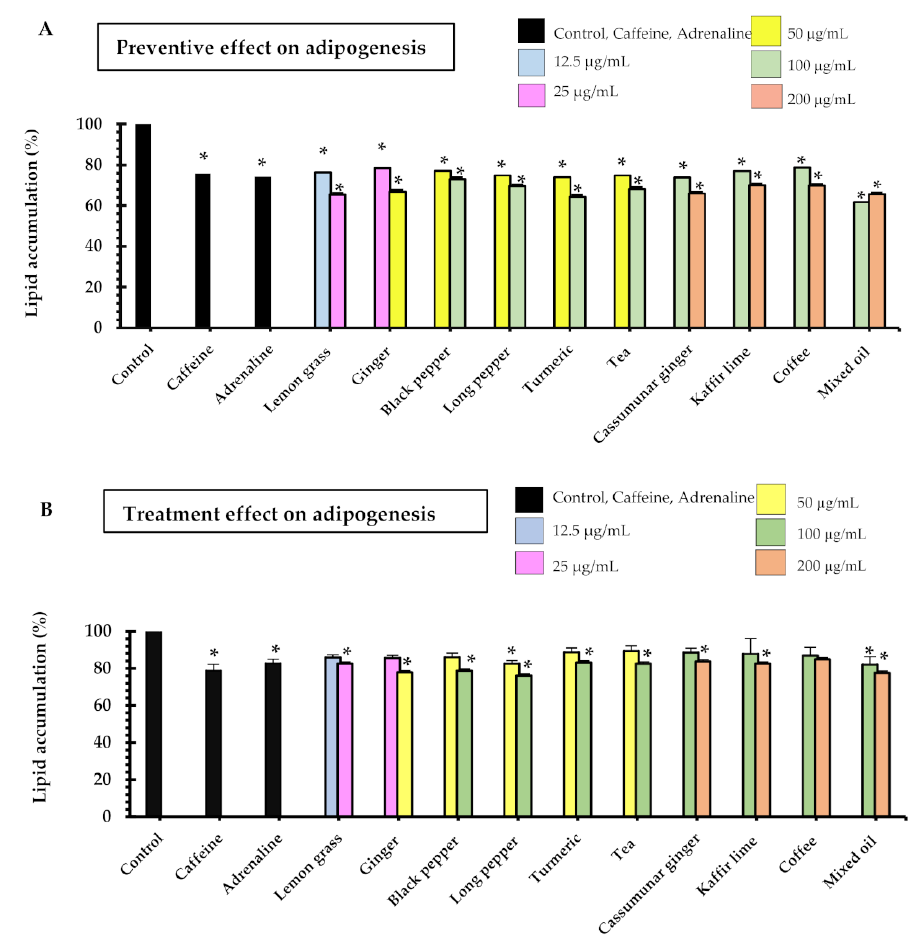
Figure 1. Lipid accumulation in 3T3-L1 adipocytes after treated with essential oil, extracts and positive controls (adrenaline 0.1 mM or 18.3 µ g/mL and caffeine 1 mM or 194.2 µ g/mL); ( A ) in the preventive experiments where the pre-adipocytes were treated with the samples during the differentiation on days 3, 5 and 7, and ( B ) in the treatment experiments where the samples were added after the pre-adipocytes were differentiated to adipocytes (on day 9) and incubated for one day. The lipid accumulation was measured by Oil Red O assay, and the results are expressed as the mean ± SEM of triplicate tests. Data expressed in percentage in comparison with control. One-way ANOVA showed significant value, * p < 0.05 as compared to